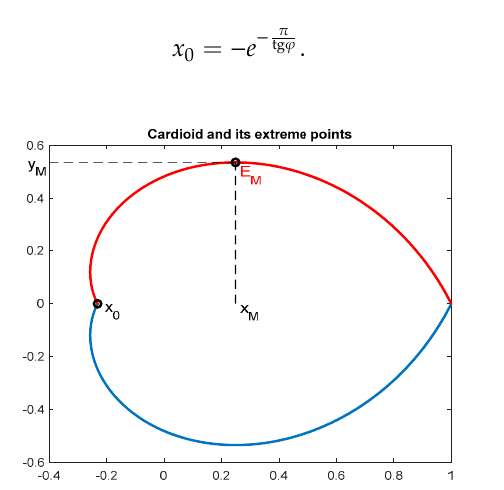
Figure 5. Extreme points of a logarithmic spiral, Equation (13): Upper point, E M , intersection with negative real axis x 0 .